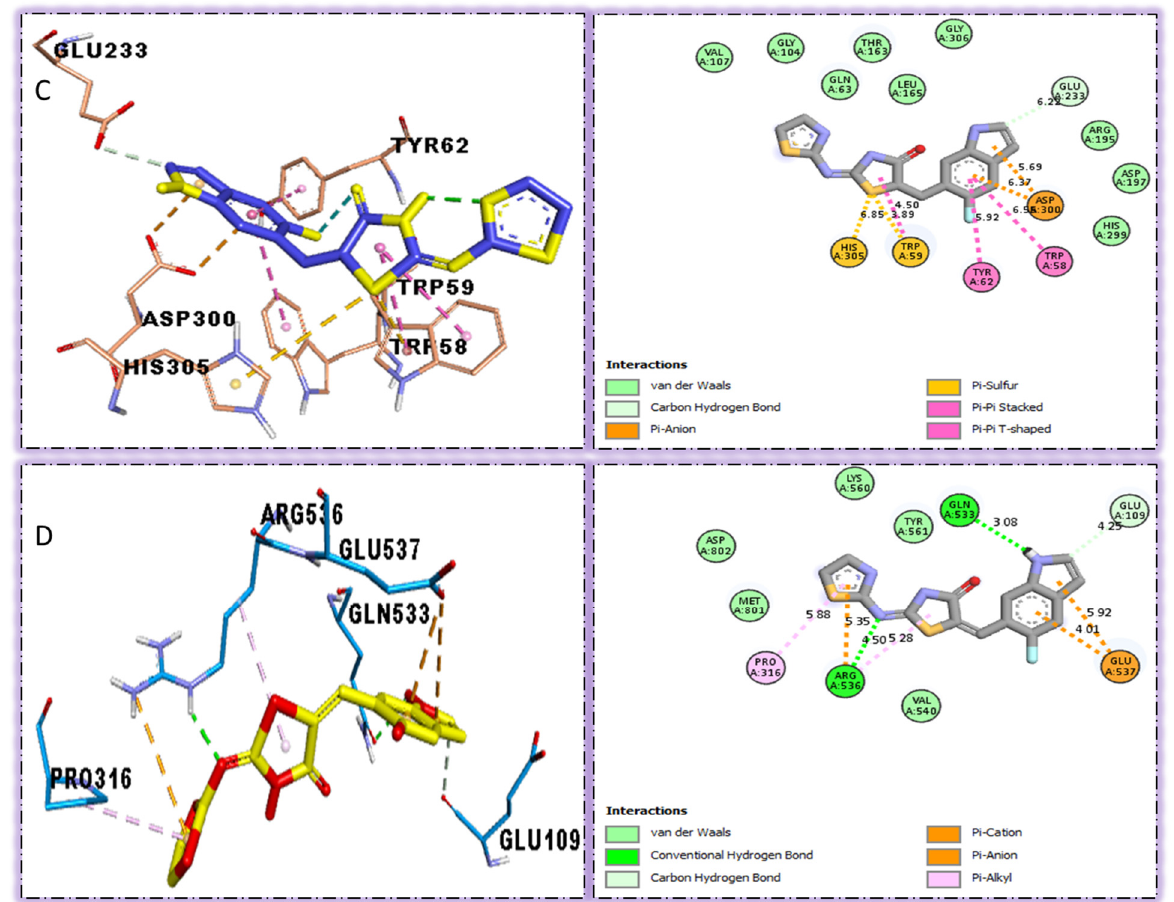
Figure 6. The surfaces of the relevant enzymes are shown by the PLI profiles for powerful drugs against Alpha-amylase and Alpha-glucosidase ( C , D ). The PLI profile for chemical 5 is shown by the letters ( C , D ). Table 3. Represent the binding affinities and best mode RMSD of analog 5 against Alpha-amylase and Alpha-glucosidase .